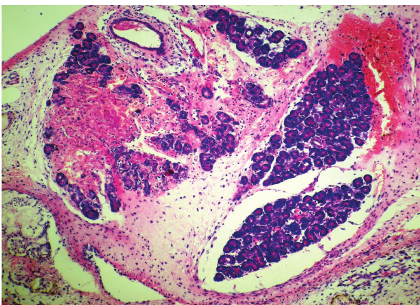
Figure 9: Histopathologic sections of pancreas (HE, x100), D: EAEEN group. The pancreas of EAEEN group showed significant reduction in necrosis, edema, and inflammatory cells infiltration as compared with those in control group, EEN group and emodin group. EAEEN: emodin-assisted early enteral nutrition EEN: early enteral nutrition.